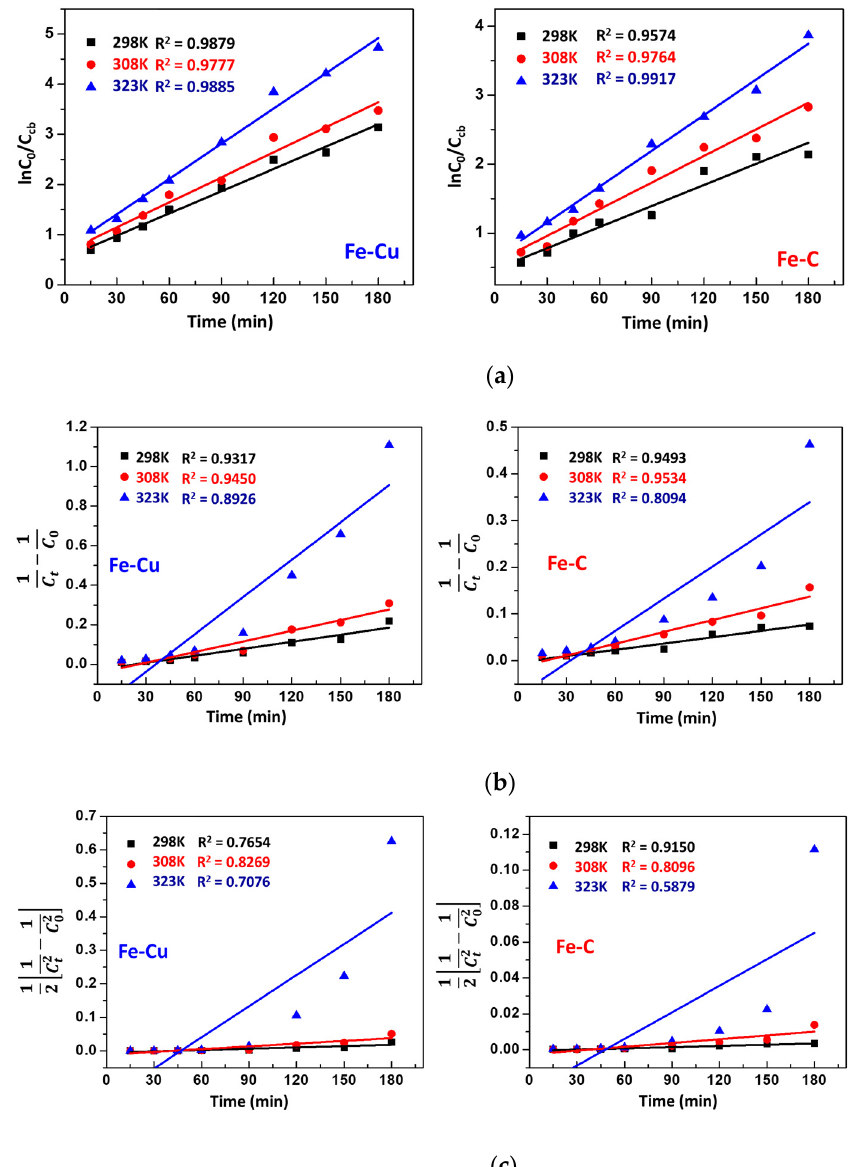
Figure 8. ( a ) The apparent first-order kinetic equation of Fe-Cu and Fe-C materials at 298, 308 and